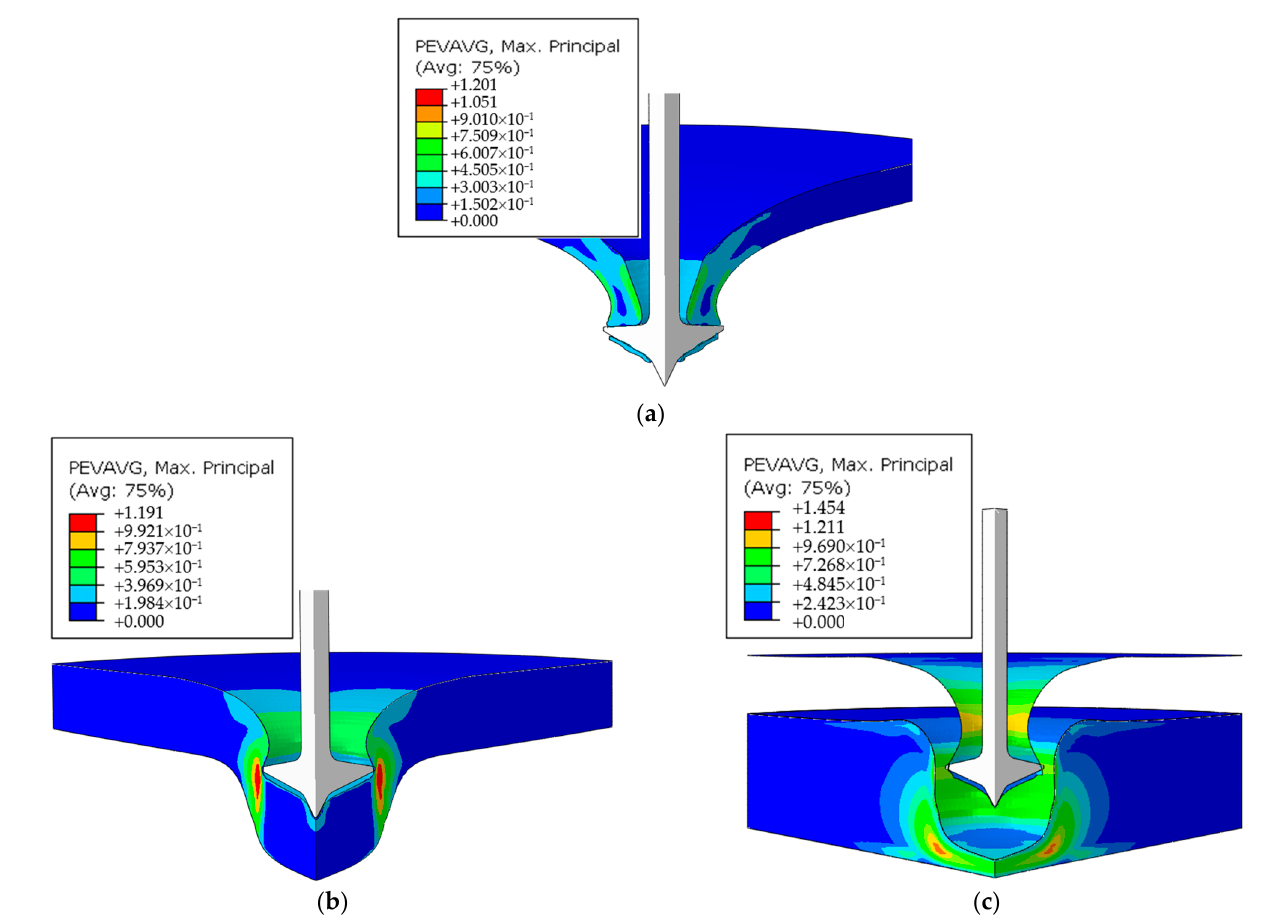
Figure 4. Plastic strain (PE) contours for simulation of centrifuge test FS9: ( a ) 1st clay layer; ( b ) 2nd sand layer; ( c ) 3rth clay layer